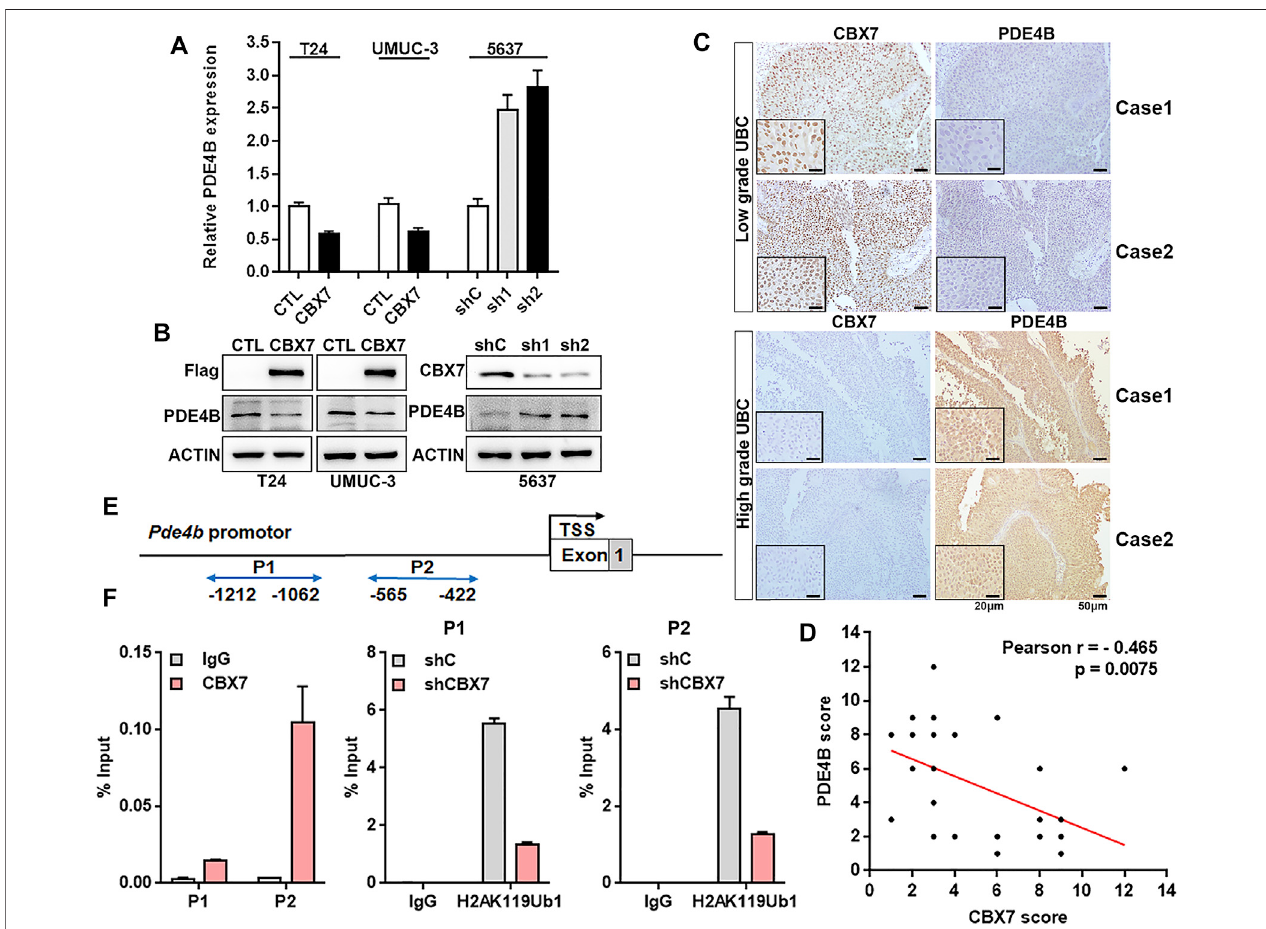
FIGURE 6 | CBX7 transcriptionally represses PDE4B in a PRC1-dependent manner (A,B) PDE4B mRNA and protein level upon CBX7 knockdown or overexpression were measured by qRT-PCR (A) and western blotting (B) . (C) representative IHC staining images of CBX7 and PDE4B expression in low-grade and high-grade patients with UBC. Scale bar, 50 and 20 μ m. (D) Pearson correlation between CBX7 and PDE4B protein expression in UBC patients from IHC cohort. (E) Schematicdiagram ofthePDE4BpromoterexaminedbyChIPanalysis. (F) ChIPassayanalysisofCBX7andubH2AK119forthePDE4Bpromoterregionin5,637 cells with or without CBX7 de fi